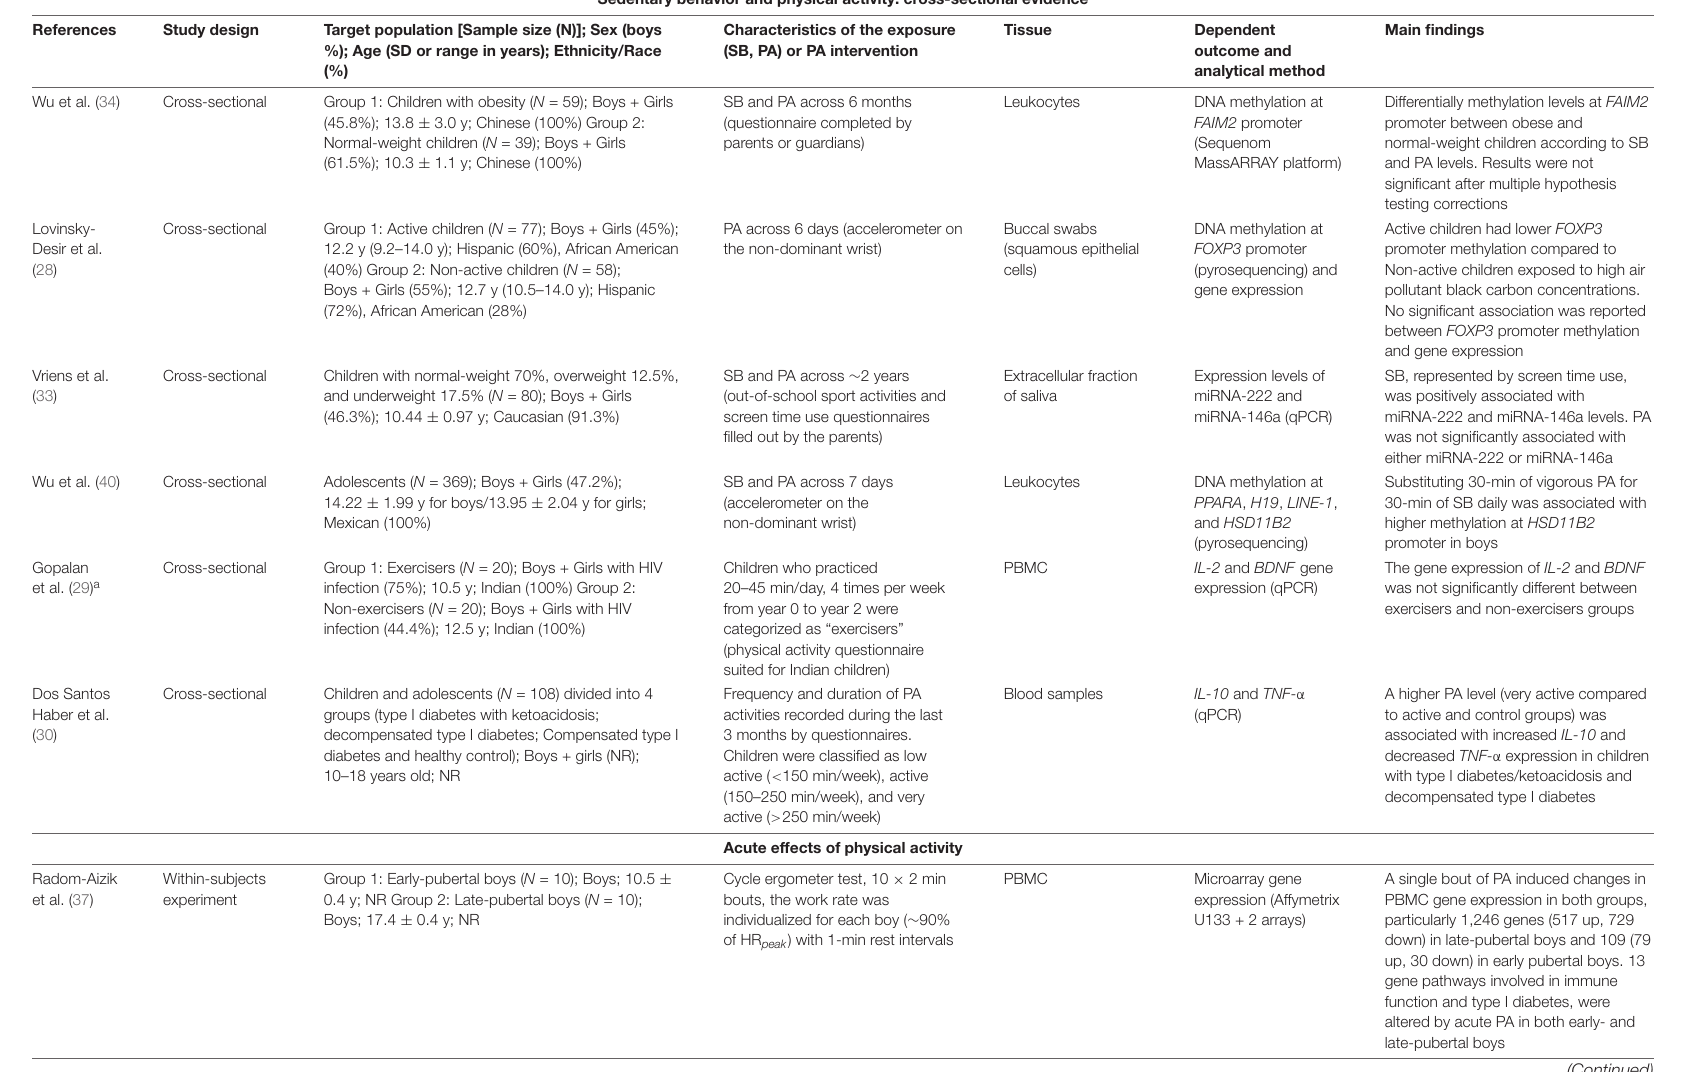
TABLE 2 | Summary of study characteristics of articles included in this